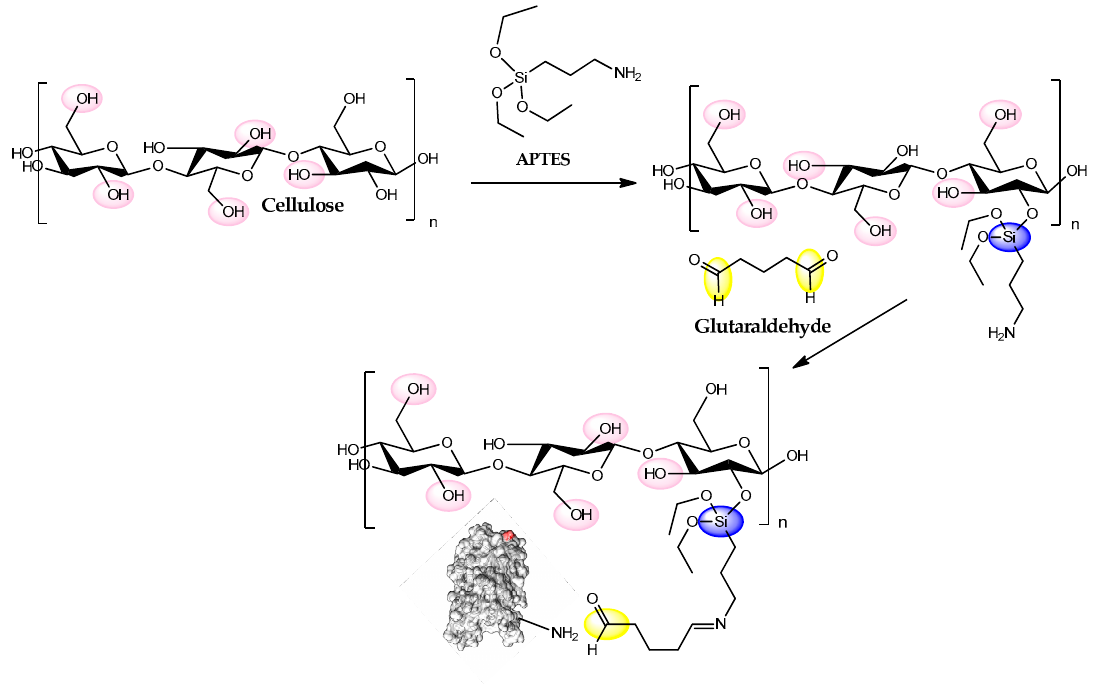
Figure 13. Schematic representation of the structure of cellulose functionalized with-aminopropyl- triethoxysilane (APTES) and glutaraldehyde .